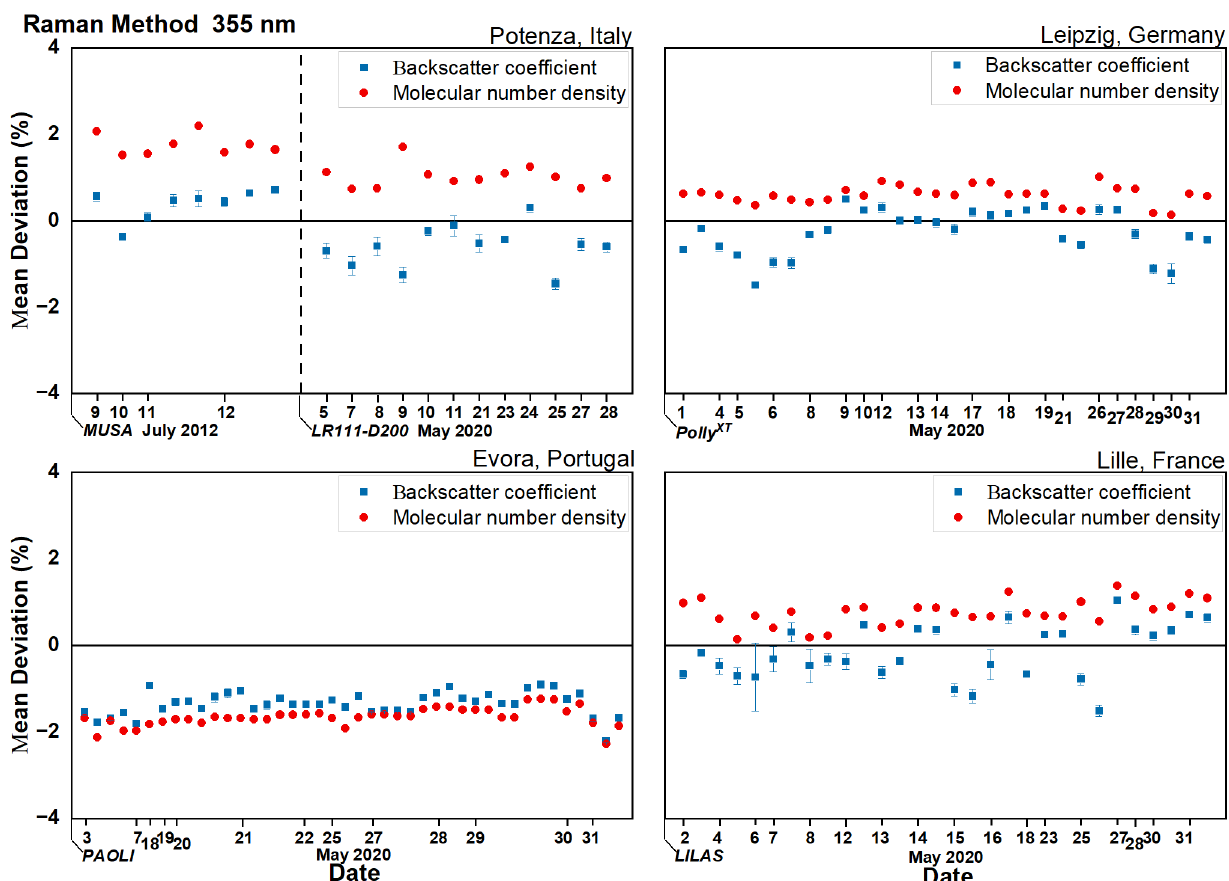
Figure 3. Mean relative deviations of Raman backscatter at 355 nm for the four stations, where the deviation refers to the difference between the values calculated with ERA5 to the values calculated with the forecast (IFS_ECMWF or GDAS). Blue and red dots represent the mean relative deviation of aerosol backscatter and molecular number density, respectively. The Date axis is not linear in time. It reports the dates (just one after the other) corresponding to the performed optical inversions. For example, for MUSA system (upper plot on the left) there is only one optical inversion available for 10 July 2012 and three for 11 July 2012.